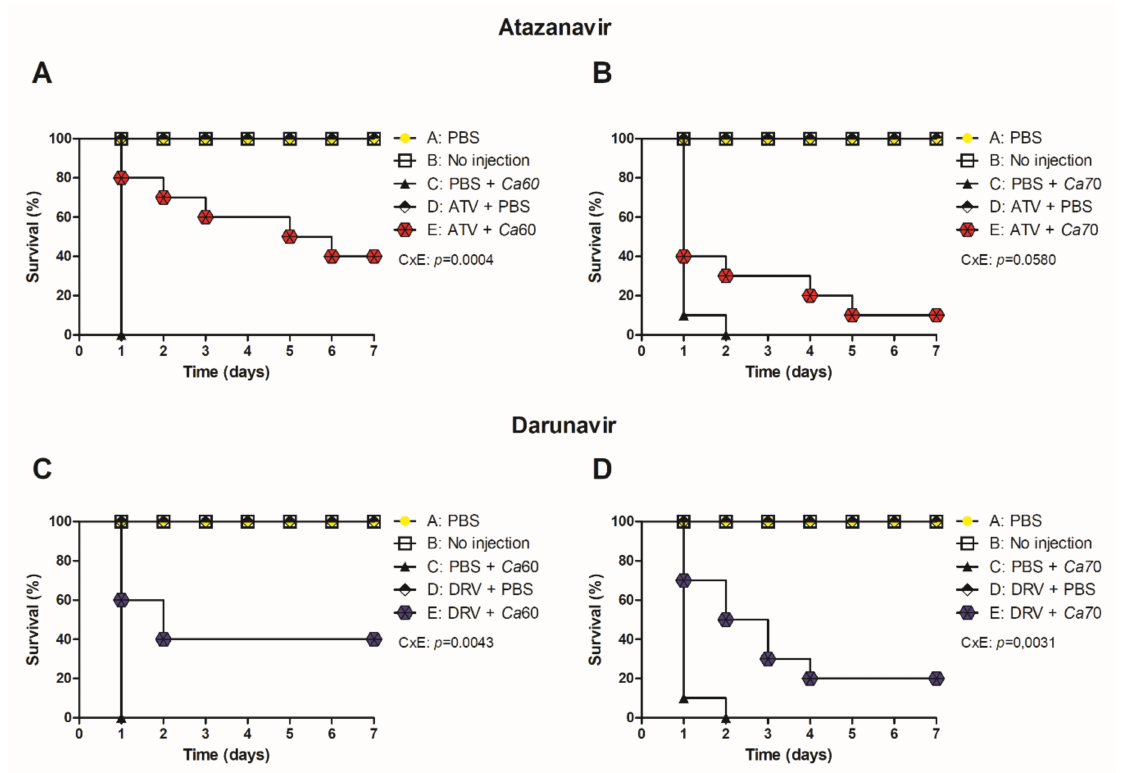
Figure 4. ATV and DRV increased the survival of G. mellonella infected with C. albicans strains. Survival curve of uninoculated G. mellonella larvae (no injection), infected with ( A , C ) C. albicans 60 and ( B , D ) C. albicans 70 and treated with PBS, atazanavir (ATV), or darunavir (DRV). Larvae were pre-treated with ATV or DRV at the last left proleg and infected with C. albicans at the last right proleg. Ca60: C. albicans 60; Ca70: C. albicans 70; DRV: darunavir; ATV: atazanavir. p <